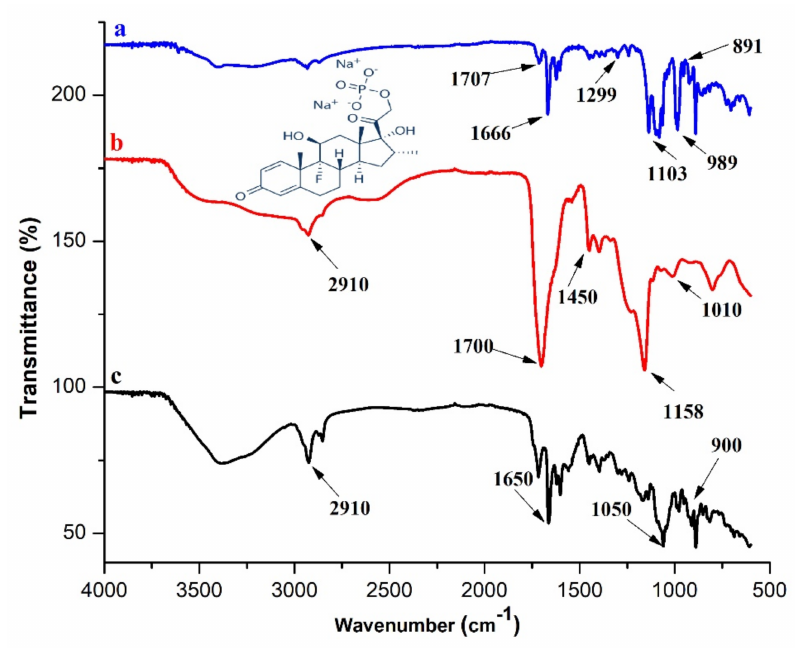
Figure 8. FTIR spectrum of: ( a ) DSP, ( b ) blank, and ( c ) loaded